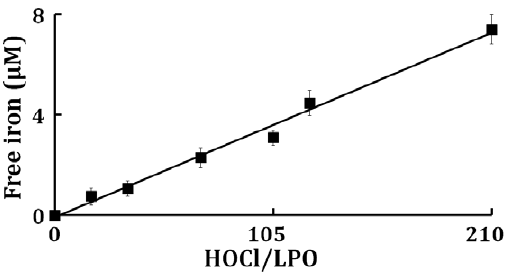
Figure 7. Release of free iron from LPO following treatment with HOCl. 10 m M of LPO-Fe(III) were incubated with increasing HOCl concentrations (0, 175, 350, 700, 1050, 1400, and 2100 m M) for 30 minutes, at 25 u C. Free iron was assayed colorimetrically using ferrozine (for details see Materials and Methods section). Experiments were carried out in sodium phosphate buffer (0.2 M at pH 7.0). These data are representative of three independent experiments.